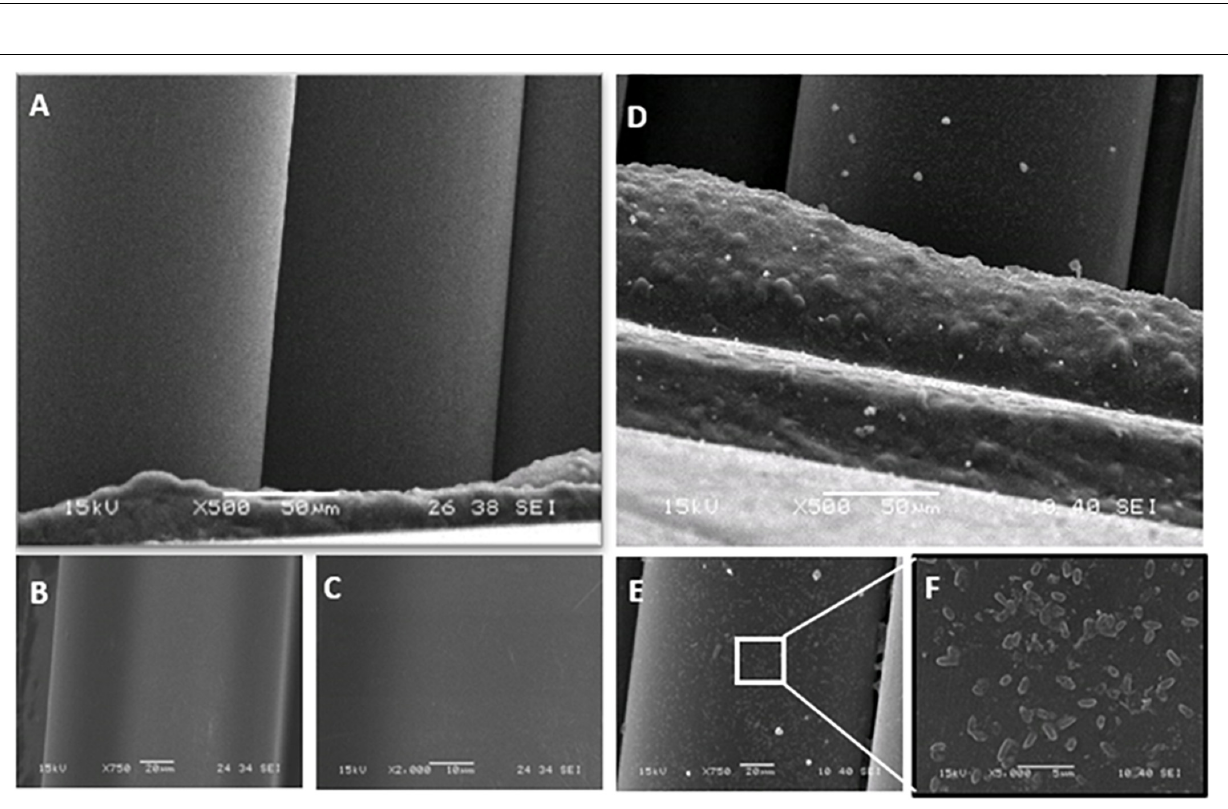
Frontiers in Microbiology |